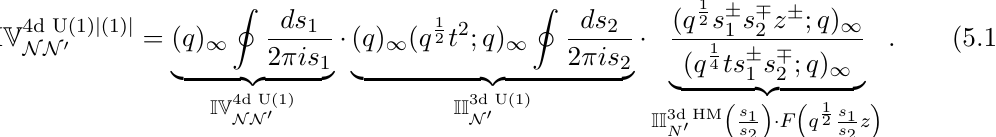
Figure 11 . The brane constructions of the configuration 4d U( N ) and its mirror corner configuration that has no gauge N (cid:31)